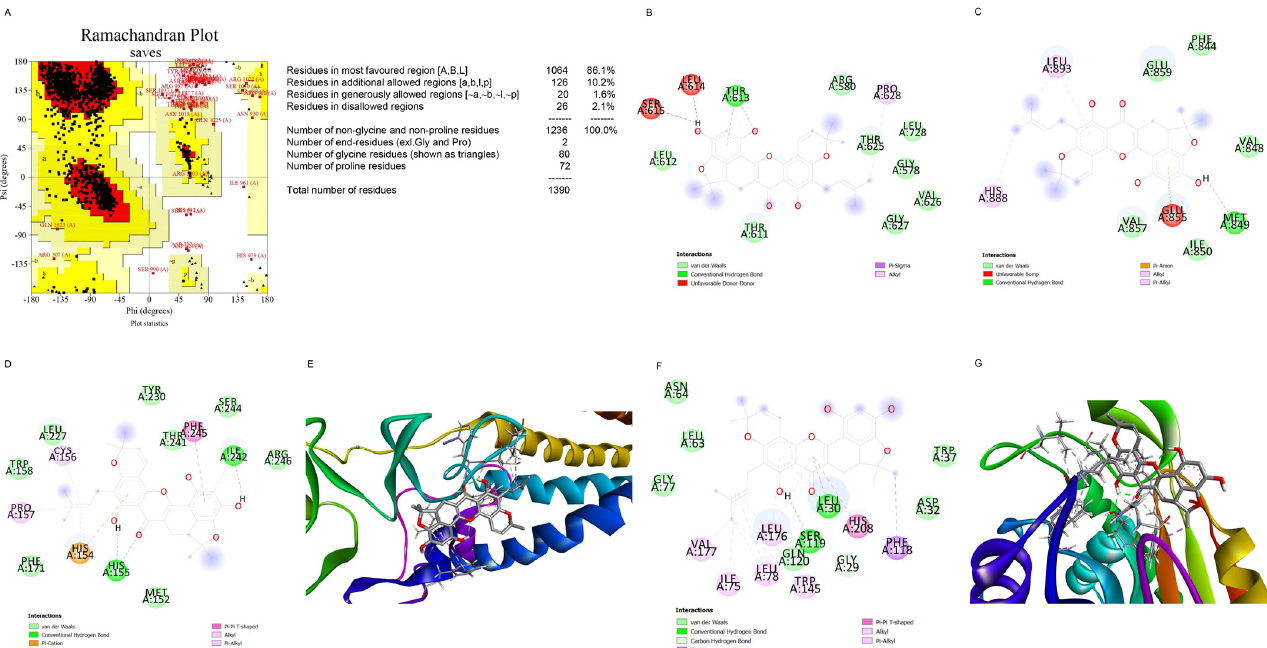
Figure 6. Molecular docking between c-Met and artonin F. ( A ) Ramachandran plot of c-Met model. ( B ) Interaction of c-Met and artonin F at near C624 residue. ( C ) Interaction of c-Met and artonin F at near C894 residue. ( D , E ) The 2D and 3D map interaction of artonin F with human DHHC20 palmitoyltransferase (PDB ID 6BML). ( F , G ) The 2D and 3D map interaction of artonin F with APT1 (PDB ID 6QGN).